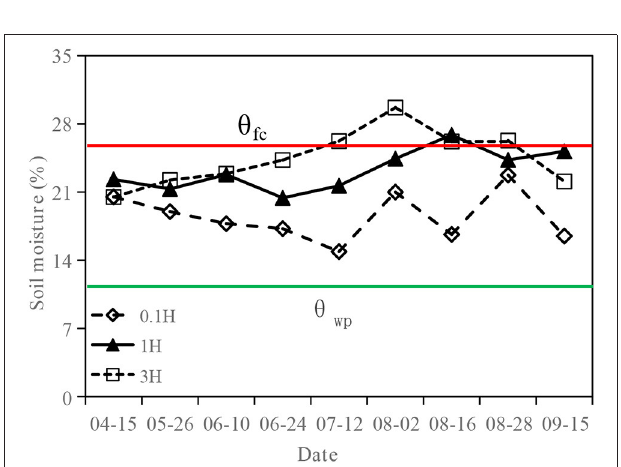
FIGURE 5 | Variation of above-ground biomass of cotton in each sampling area (0.1H, 1H, and 3H).